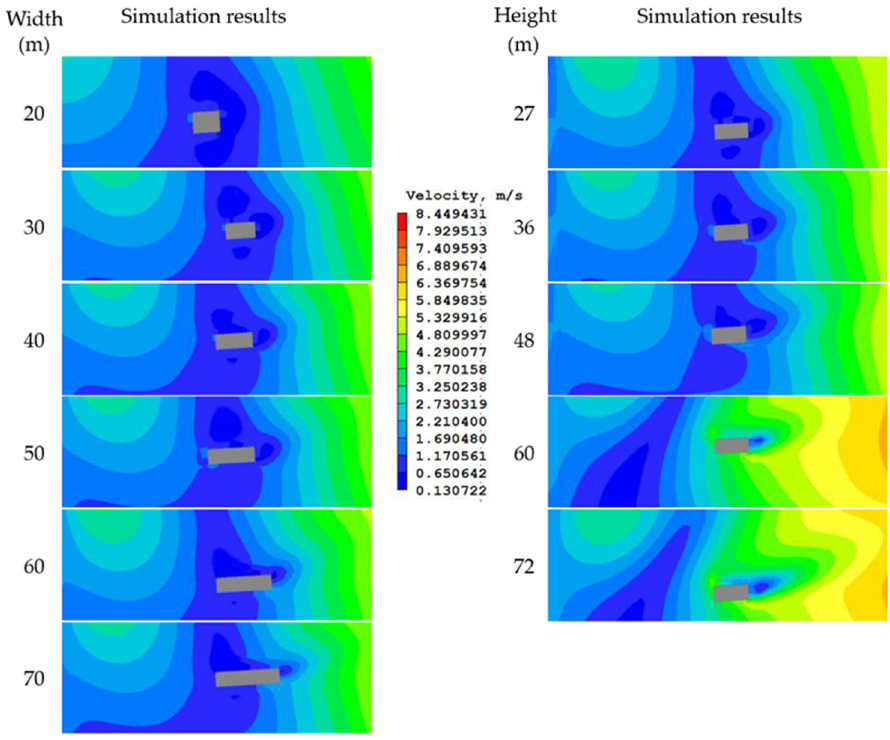
Figure 12. The CFD simulations produced with different W b and H b values.